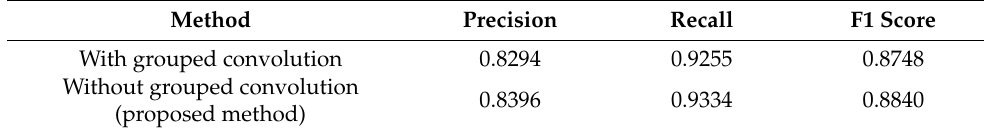
Table 5. Performance comparisons with or without grouped convolution.